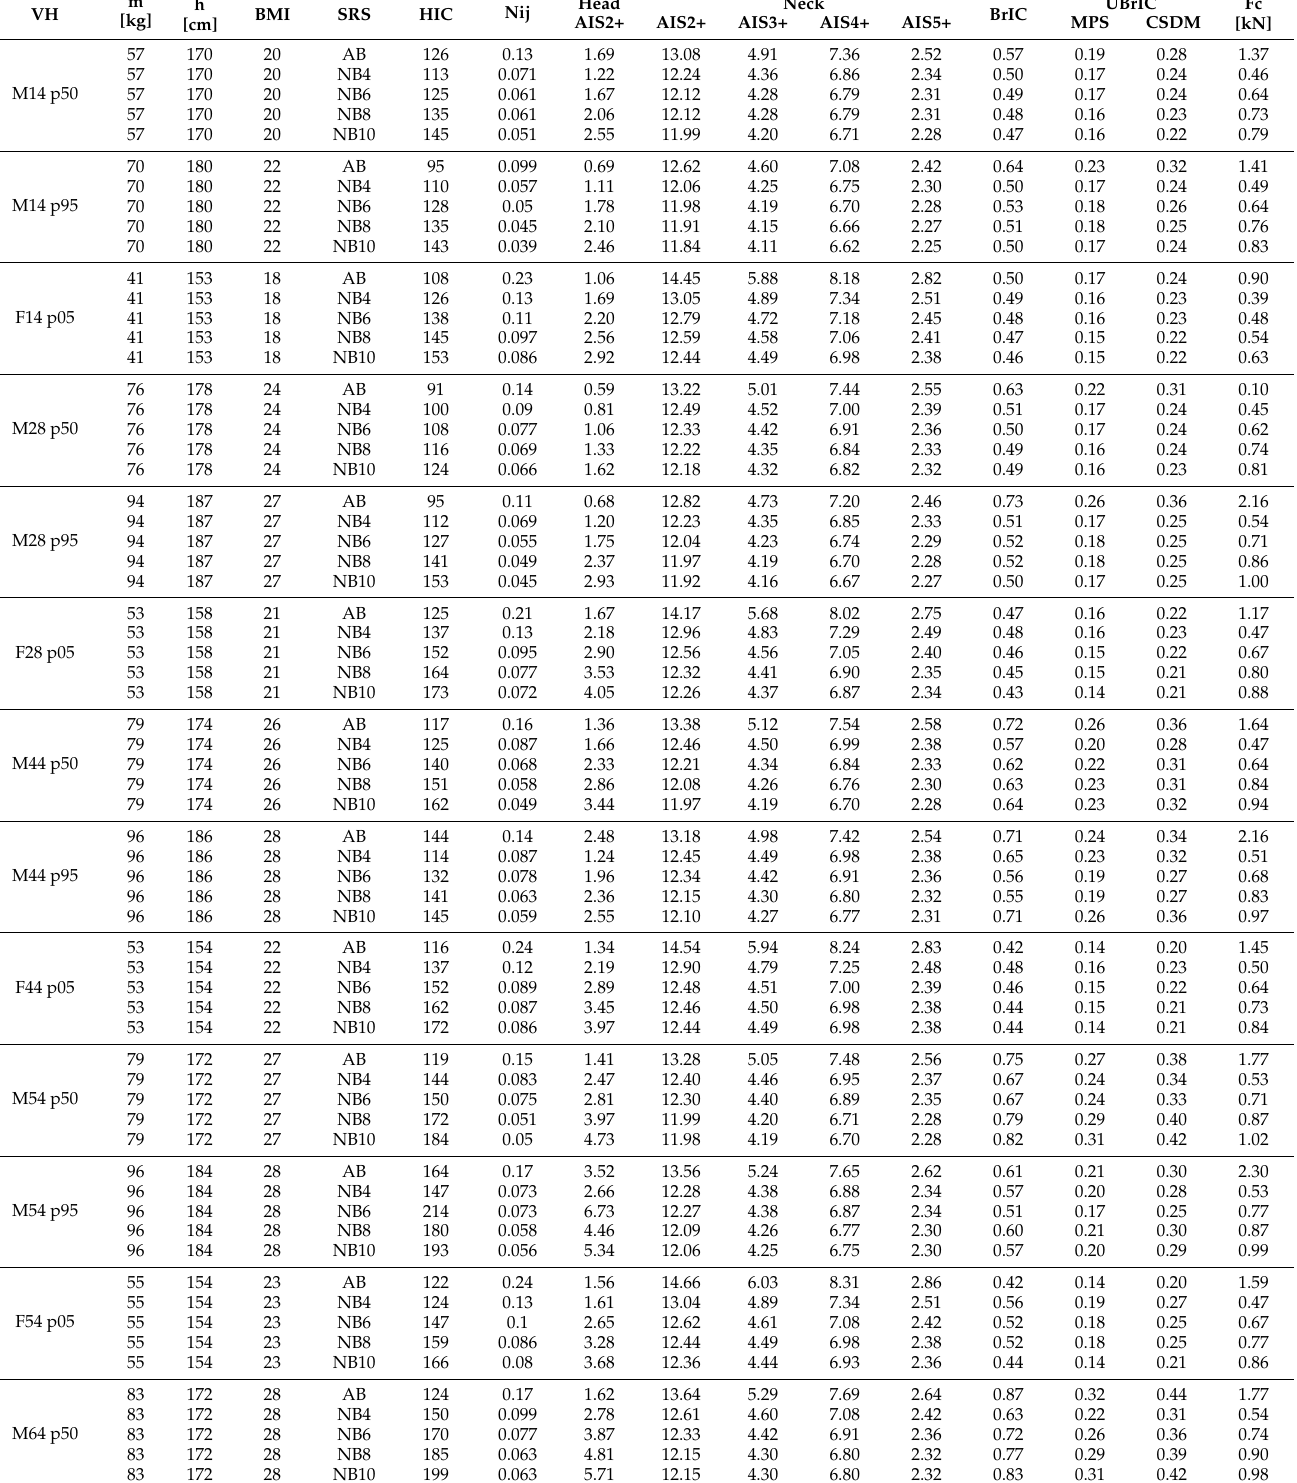
Table 2. Results of 30 km/h impact